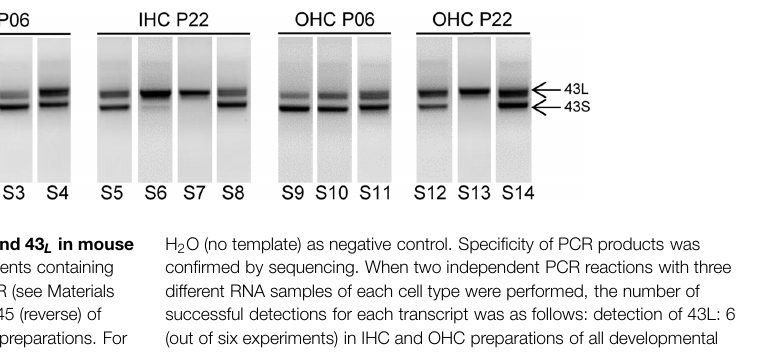
H 2 O (no template) as negative control. Specificity of PCR products was confirmed by sequencing. When two independent PCR reactions with three different RNA samples of each cell type were performed, the number of successful detections for each transcript was as follows: detection of 43L: 6 (out of six experiments) in IHC and OHC preparations of all developmental stages; detection of 43S: 4 (6) in IHC P06 and IHC P22, 6 (6) in OHC P06 and 5 (6) in OHC P22. Bp, basepair markers.